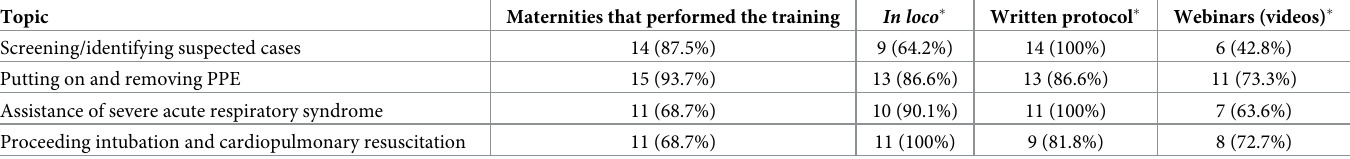
Table 3. Training health professionals in the REBRACO maternities (n =